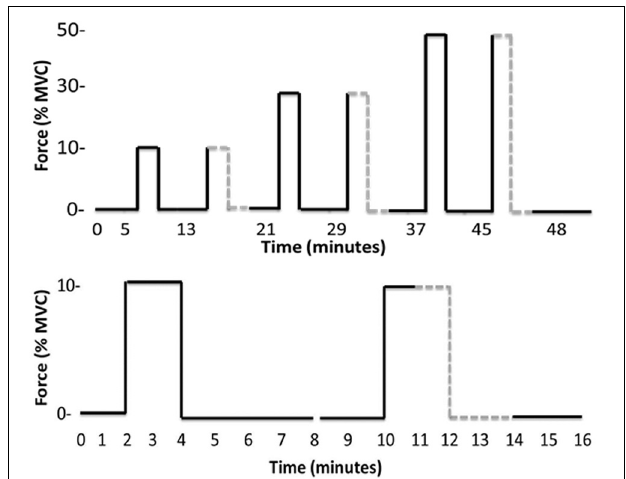
FIGURE 1 | Timelines of the entire experimental protocol (top) and the initial pair of contractions plus rest periods (bottom). The latter timeline more clearly identifies the onset and offset of ischemia (gray dashed line) and that each contraction belongs to an 8-min “block” beginning with a 2min rest and ending with a 4min